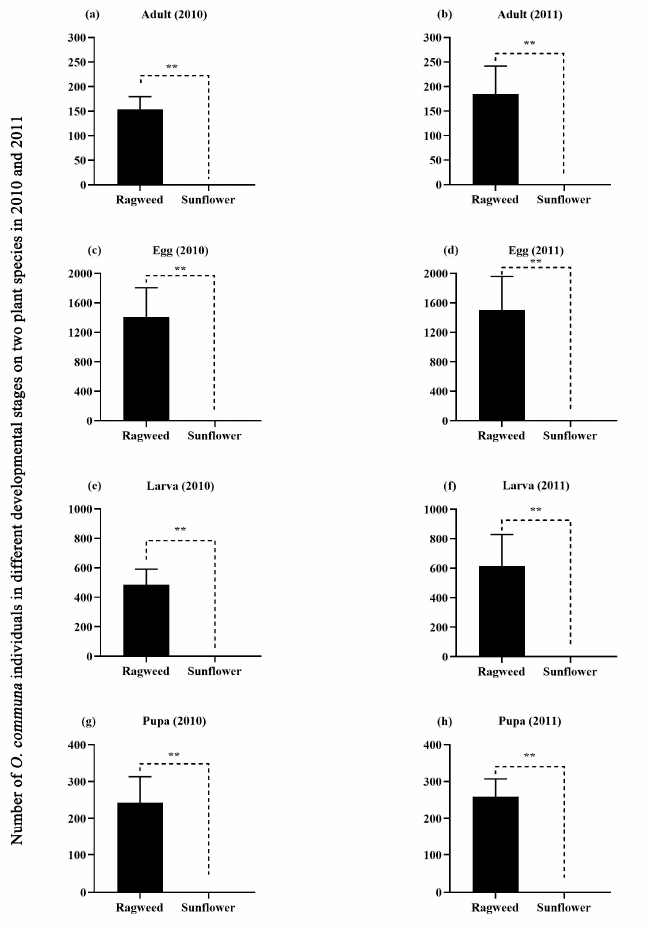
Figure 5. The number of O. communa individuals in different developmental stages on A. artemisiifolia (individuals/plant) and H. annuus (individuals/plant) planted in 2010 and 2011. All values are shown as the means ± SE. ** p < 0.01, highly significant. ( a ): the number of O. communa adults on A. artemisiifolia and H. annuus in 2010, ( b ): the number of O. communa adults on A. artemisiifolia and H. annuus in 2011,( c ): the number of O. communa eggs on A. artemisiifolia and H. annuus in 2010., ( d ): the number of O. communa eggs on A. artemisiifolia and H. annuus in 2011.,( e ): the number of O. communa larvae on A. artemisiifolia and H. annuus in 2010.,( f ): the number of O. communa larvae on A. artemisiifolia and H. annuus in 2011.,( g ): the number of O. communa pupae on A. artemisiifolia and H. annuus in 2010, ( h ): the number of O. communa pupae on A. artemisiifolia and H. annuus in 2011.